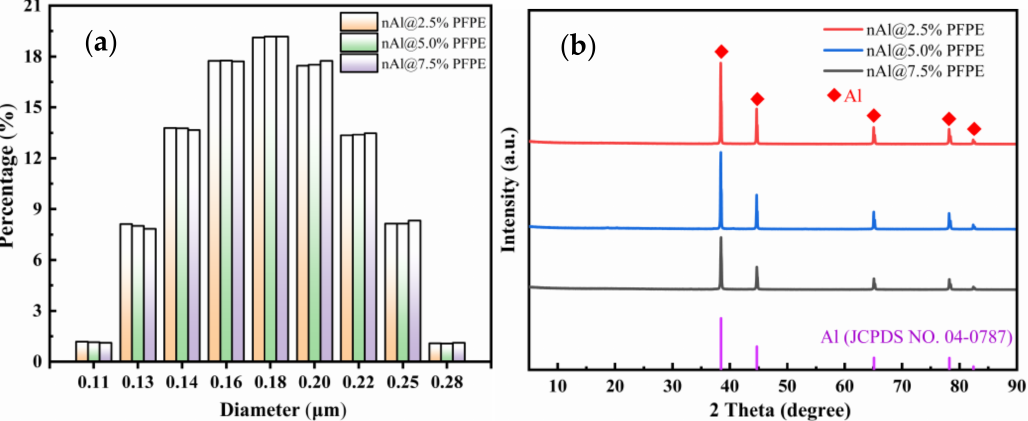
Figure 3. Particle size distribution curve ( a ) and X-ray diffraction patterns ( b ) of PFPE-functionalized Al